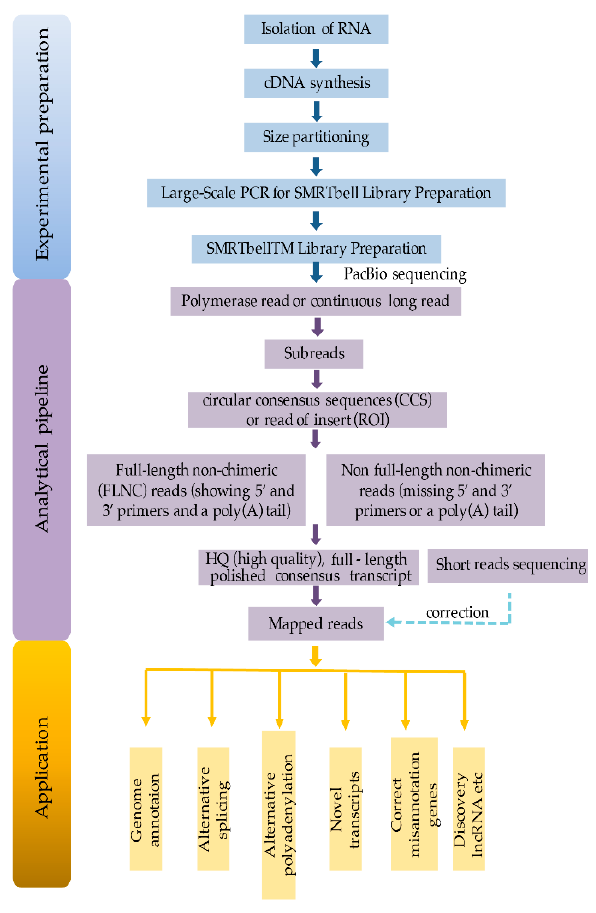
Figure 2. Schematic workflow of isoform sequencing.